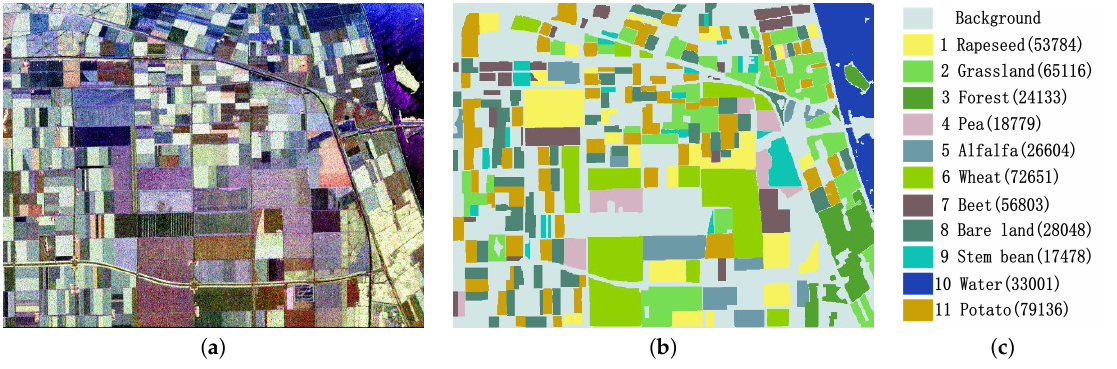
Figure 6. Flevoland dataset. ( a ) Pauli RGB. ( b ) Ground Truth. ( c )labels.